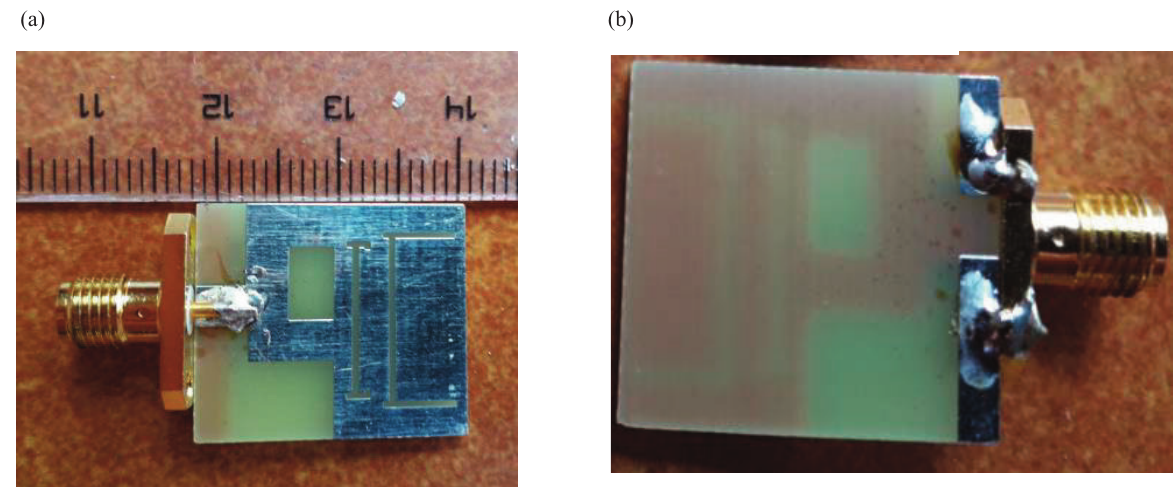
Fig. 9. The fabricated antenna prototype: (a) front view and (b) back